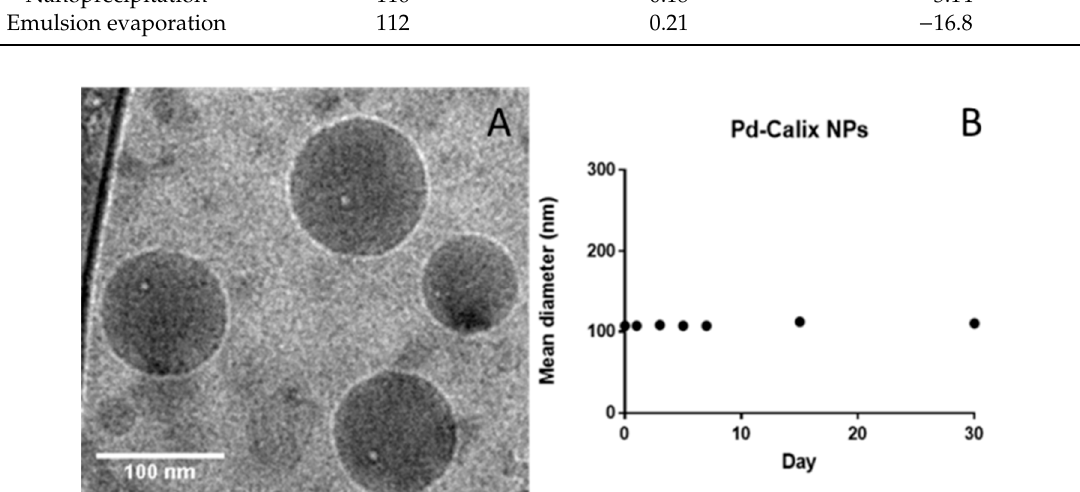
Figure 2. ( A ): Cryo-TEM images of the nanoparticles of the Pd-Calix-NS prepared by emulsion-solvent evaporation; ( B ): Evolution of the mean diameter of the nanoparticles of the Pd-Calix-NS upon incubation at 25 °C in water over one-month.